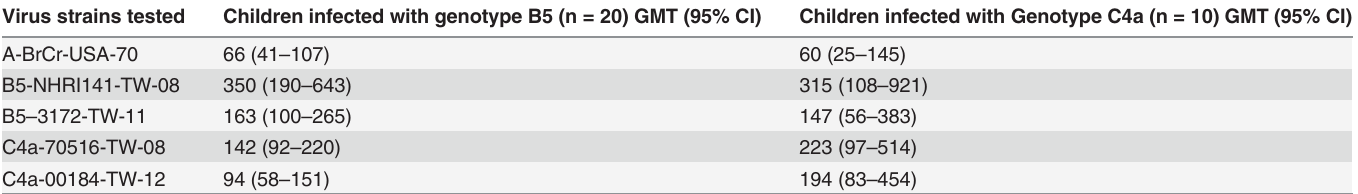
Table 2. Cross-reactive neutralizing antibody titers in children infected with EV71 C4a and B5 genotypes. Virus strains tested Children infected with genotype B5 (n = 20) GMT (95%